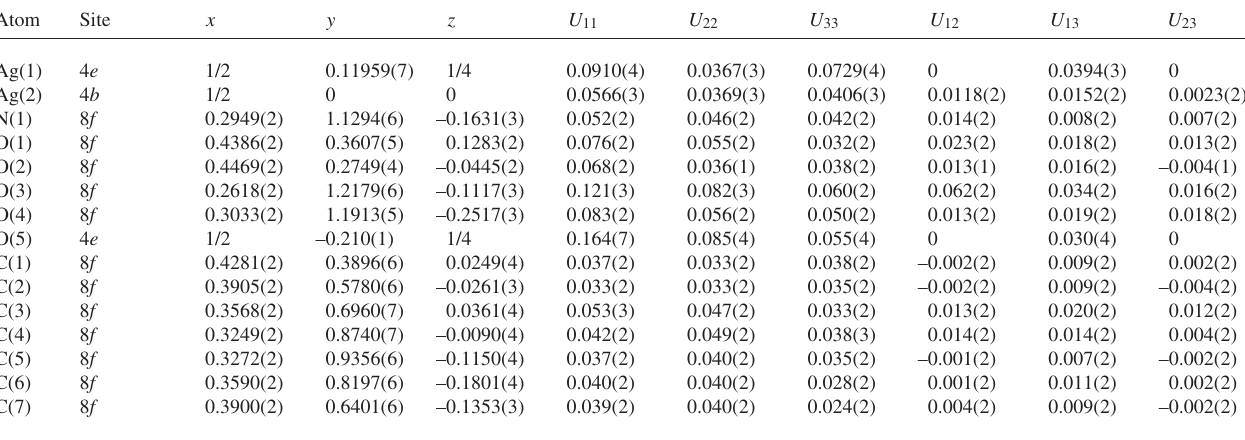
Table 3. Atomic coordinates and displacement parameters (in Å 2 )